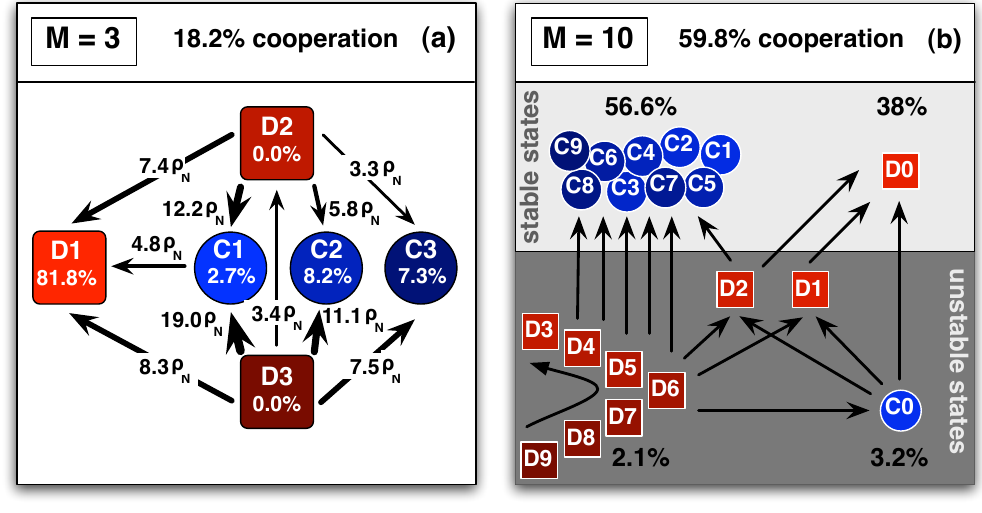
Figure 6. Transition probabilities and stationary distributions for the PD game with M = 3 (a) and M = 10 (b) types of individuals. The population spends already 59 . 8% of the time in a cooperative state when M = 10 . Numbering C’s and D’s according to their type, C0 ( D0 ) being the slowest cooperator (defector), we see that increasing M splits the “outflow” of fast defectors among a wide range of different possibilities. As a result, cooperation emerges, since only few types of defectors are evolutionarily stable, whereas the vast majority of cooperative types work as “flow sinks”. ( N = 100 , T = 2 . 1 , R = 2 , S = 0 . 9 , P = 1 , c = 0 . 16 , β = 0 . 01 , δ = 0 . 3 ). Figure reproduced from [62].